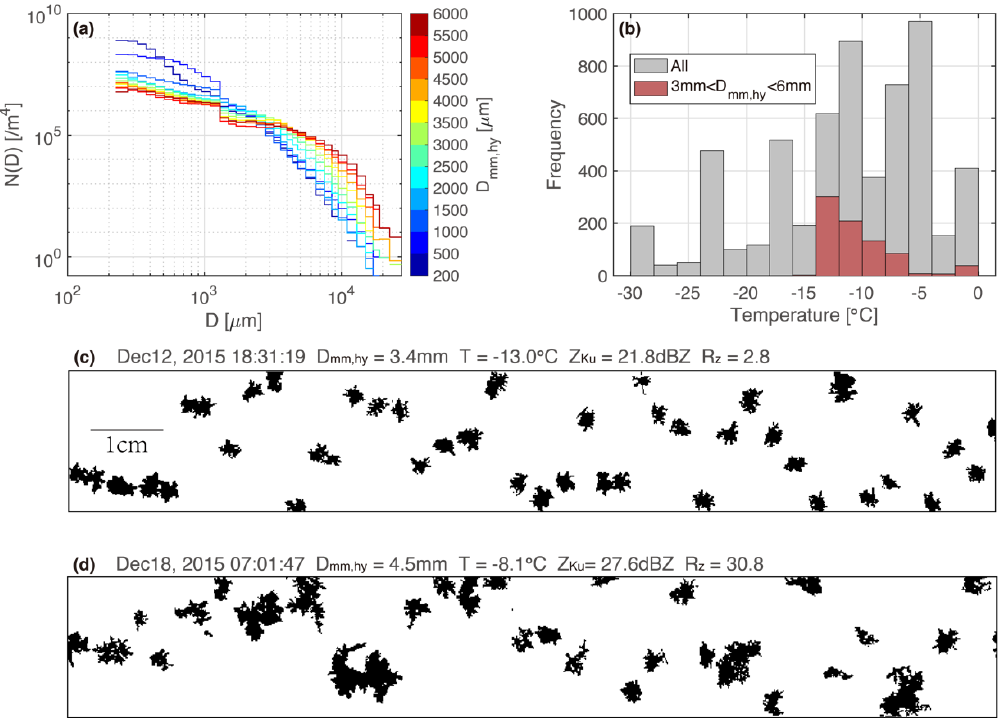
Figure 5. ( a ) Averaged PSDs for different D mm,hy ranges indicated by the color bar; ( b ) Histograms of temperature for all ice clouds (gray) and D mm,hy between 3–6 mm (red); ( c , d ) typical particle images from HVPS probe for D mm,hy between 3–6 mm.